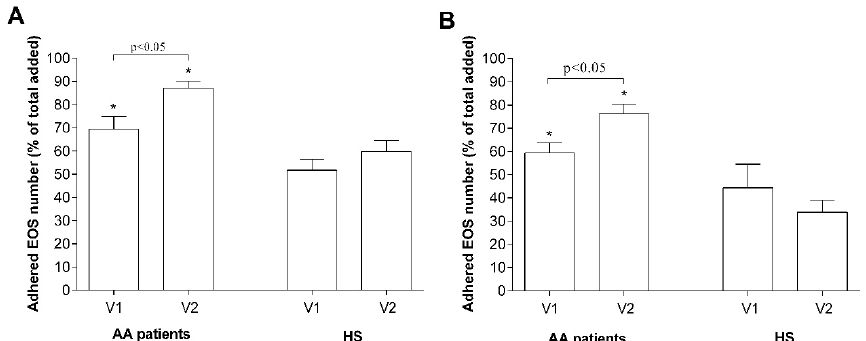
Figure 8. Bronchial allergen challenge effect on the efficiency of eosinophil adhesion. ( A ) Eosinophils adhesion in co-culture with ASM cells; ( B ) eosinophils adhesion in co-culture with pulmonary fibroblasts. Results from independent experiments of AA— n = 11, HS— n = 11; EOS—Eosinophils, AA—Allergic asthma, HS—Healthy subjects. * p < 0.05 compared with the adhesion of the healthy eosinophil group. V1—Visit 1 (before bronchial allergen challenge); V2—Visit 2 (24 h after